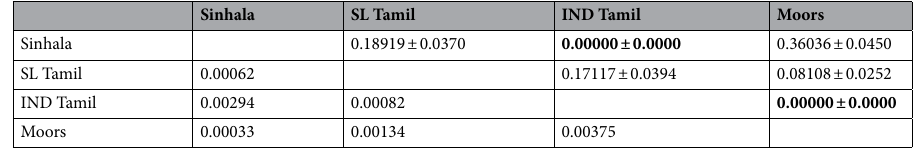
Table 2. Pairwise Fst and P values values for four ethnicities. Below diagonal: pairwise Fst values, above diagonal: P values, significant P values are indicated in bold font.